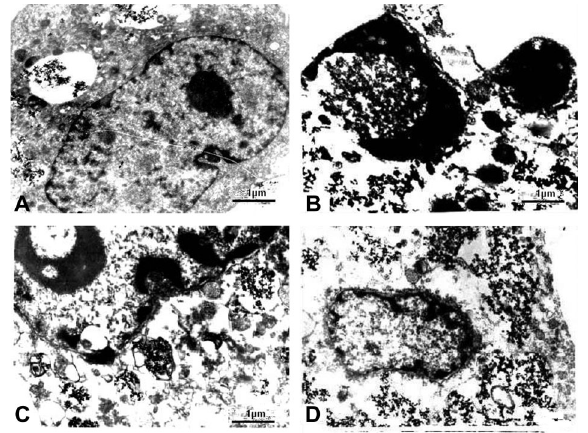
Figure 2. Morphology of SMMC-7721 cells after treatment. A , spiking group (8 g/L Fe 2 O 3 , no radiation); B - D , MFH groups (4, 6 and 8 g/L Fe 2 O 3 , respectively). MFH: magnetic fluid hyperthermia.